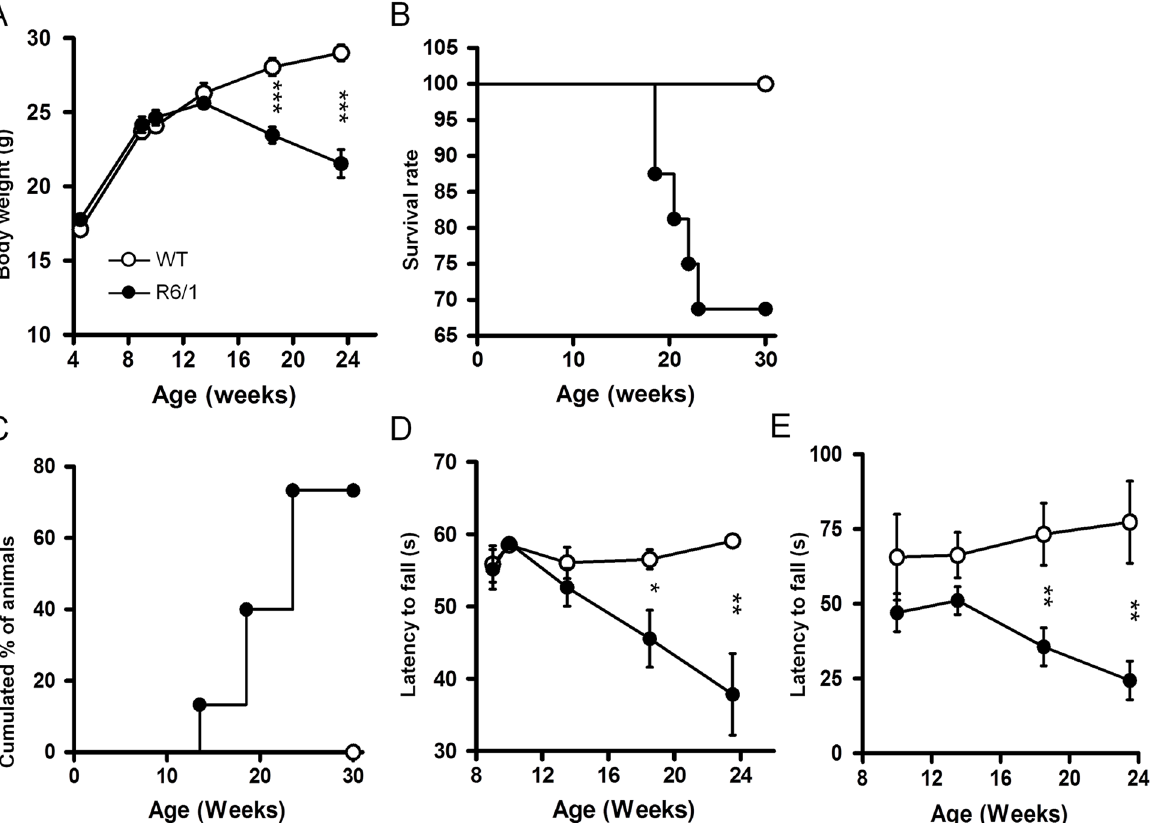
Fig 5. The evolution of body weight (A), survival rate (B), hindlimb clasping (C), inverted grip test (D) and Rotarod test performance (E) in R6/1 mice. * R6/1 mice significantly different from age-matched WT littermates at p < .05, ** at p < .01, *** at p <